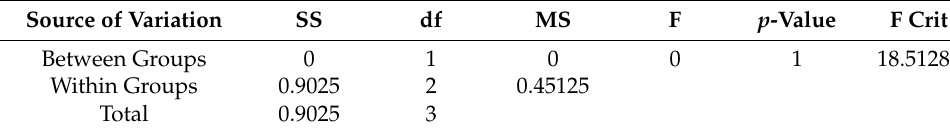
Figure 5. Effect of curing age at ambient temperature on UCS. Table 3. Statistical single ANOVA test.